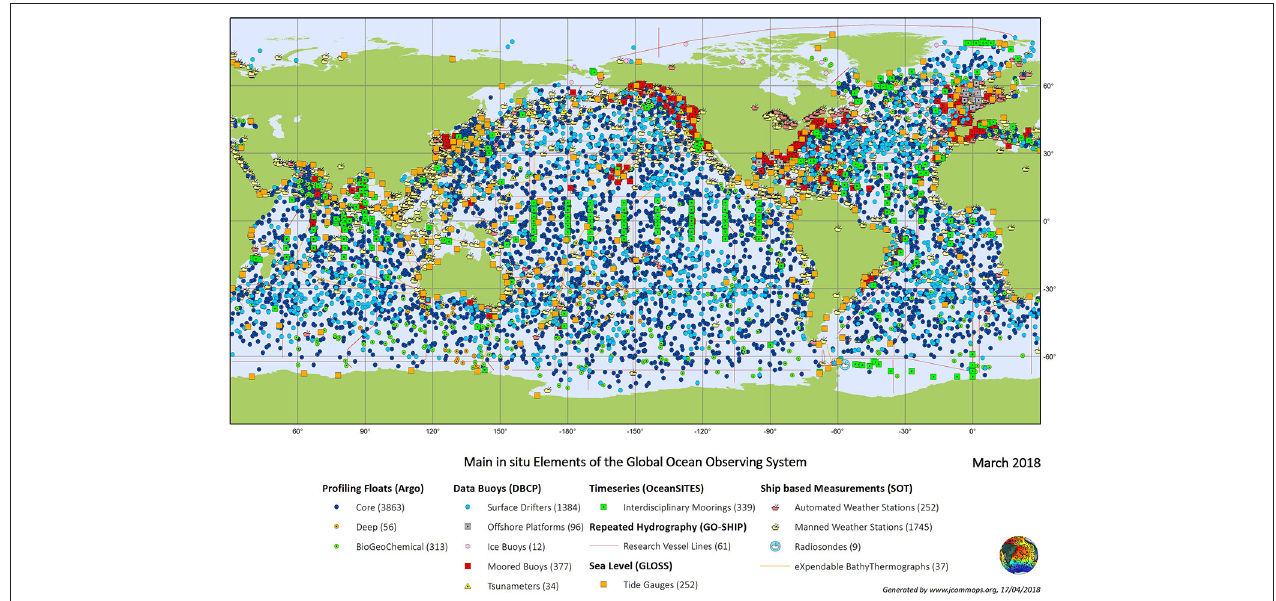
FIGURE 4 | The status in March 2018 of the elements of the GOOS, as tracked by the Joint Technical Commission on Marine Meteorology (JCOMM) 8 . Updated monthly summary maps available at JCOMM, 2018 (http://www.jcommops.org/). The dots representing platform locations are sized to be visible, but the actual coverage of the ocean remains